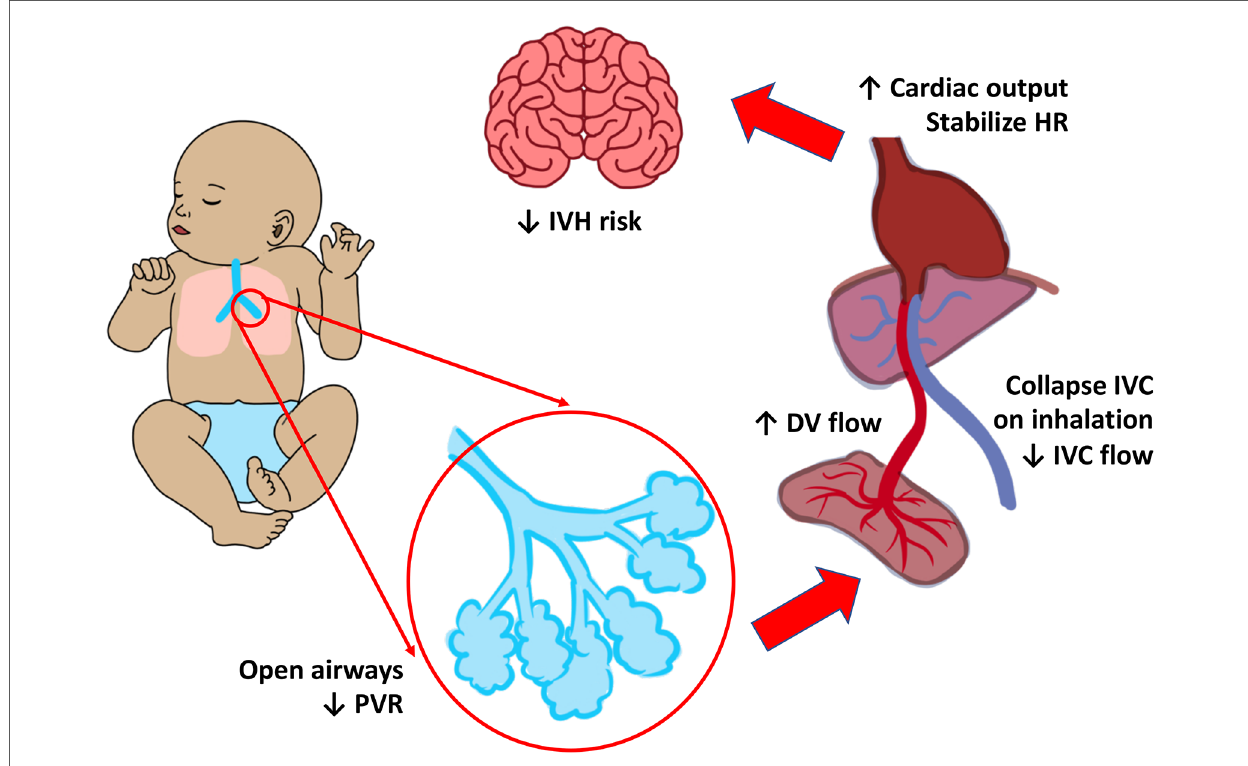
FIGURE 2 Cardiorespiratory changes during respiration before cord clamping. Respiration and lung recruitment drops the pulmonary vascular resistance (PVR), collapses the inferior vena cava (IVC), and thereby increases the fl ow of blood from the ductus venosus (DV). This increases cardiac output (CO) which in turn stabilizes the heart rate (HR), blood pressure (BP), and reduce the risk of intraventricular hemorrhage